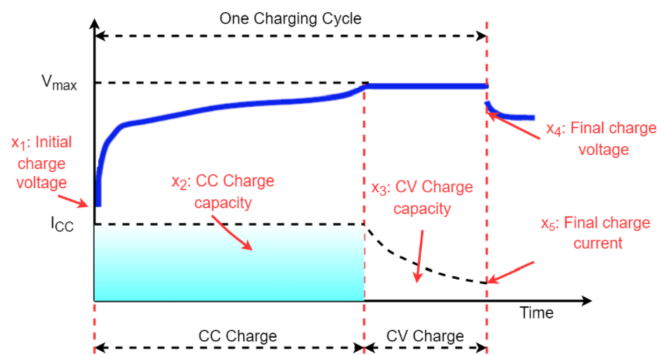
Figure 5. CC-CV Charging Cycle and crucial features in that